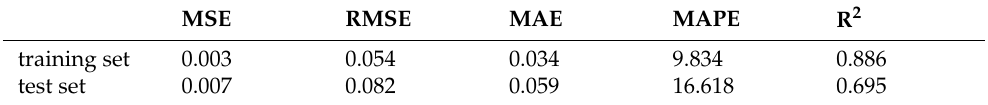
Table 9. The performance measurement of GEE by